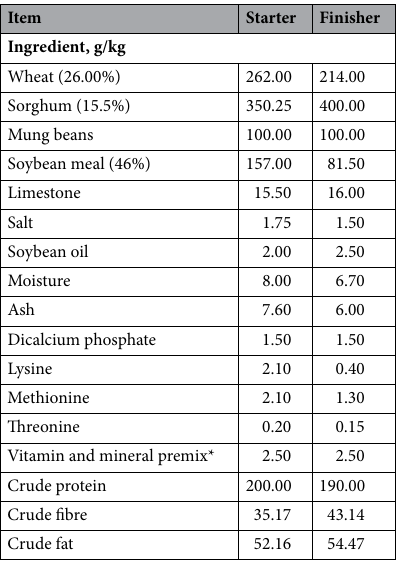
Table 9. Ingredient composition and calculated nutrient of basal diet used for the study. *Nutrition value per Kg of vitamin and mineral premix contains 140,000 IU of vitamin A, 70 mg of vitamin E, 3000 IU of vitamin D3, 4 mg of vitamin K, 3 mg of thiamine, 10 mg of vitaminB2, 8 mg of vitamin B6, 0.04 mg of vitamin B12, 48 mg of niacin, 20 mg of calcium d-pantothenate, 500 mg of choline chloride, 0.20 mg of biotin, 1.8 mg of folic acid, 80 mg of manganese, 70 mg of zinc, 50 mg of iron, 10 mg of copper, 3 mg of iodine, 0.4 mg of selenium, and 0.2 mg of